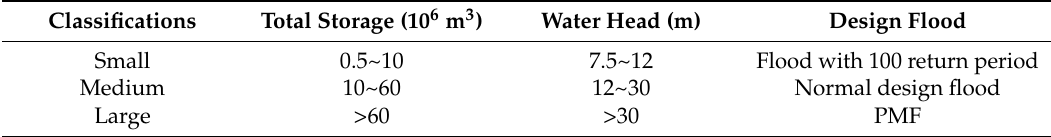
Table 15. Design flood control standard for reservoir engineering in